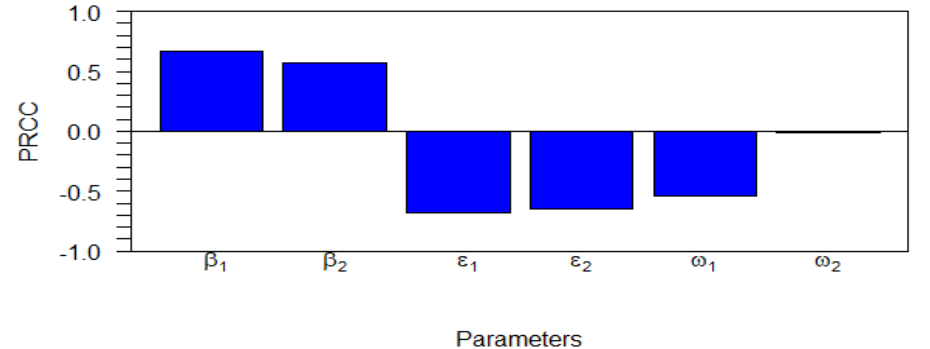
Figure 2. Tornados plot for some significant model